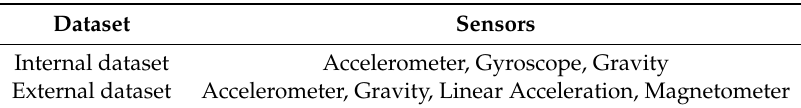
Table 1. Sensors registered in each